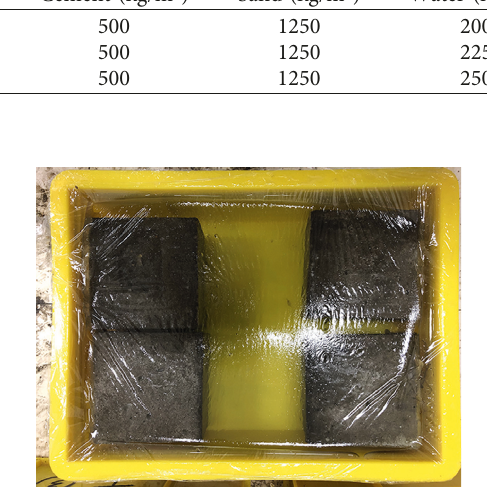
Figure 4: Diffusion tests.